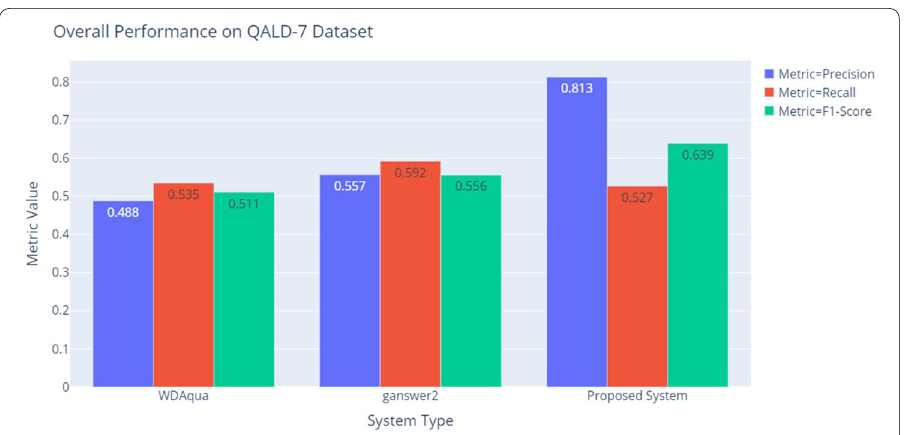
Fig. 6 End-to-end performance on the QALD-7